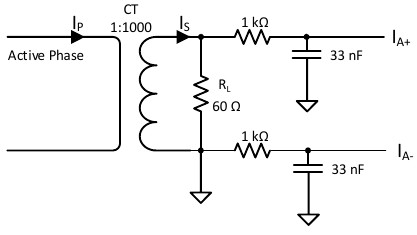
Figure 4. Signal conditioning circuit to current ADC.